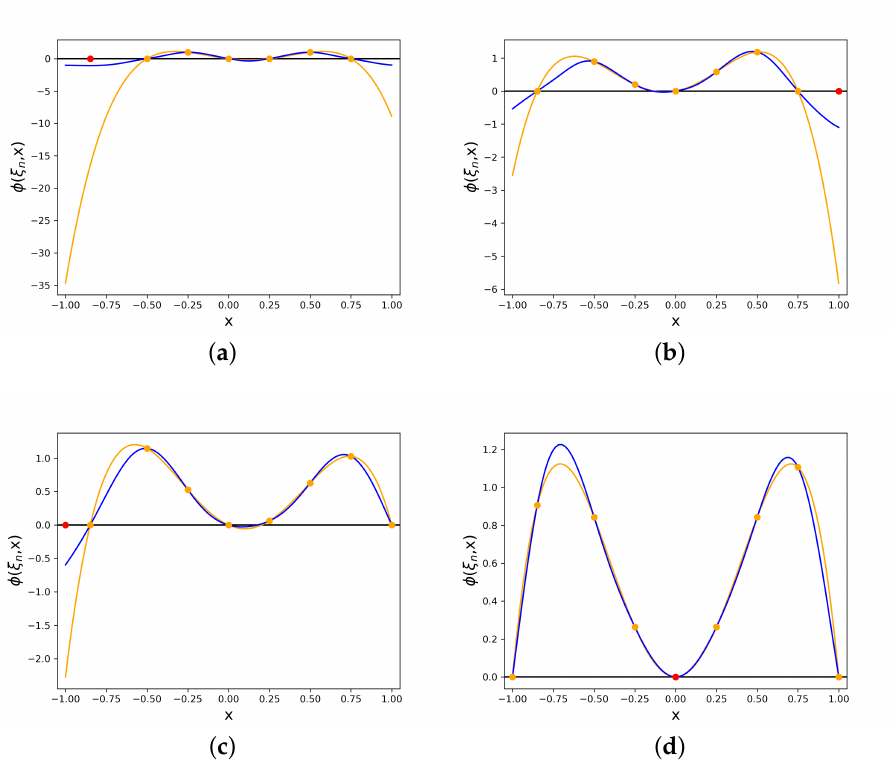
Figure 2. Illustration of the point acquisition in the ( a ) first, ( b ) second, ( c ) third and ( d ) fourth iteration of the ADA-GPR with the D-Criterion for a unitless mathematical example. The directional derivative φ D (orange), the acquisition function (blue) as well as the current candidate points X n (orange) and the new selected point x n + 1 (red) are